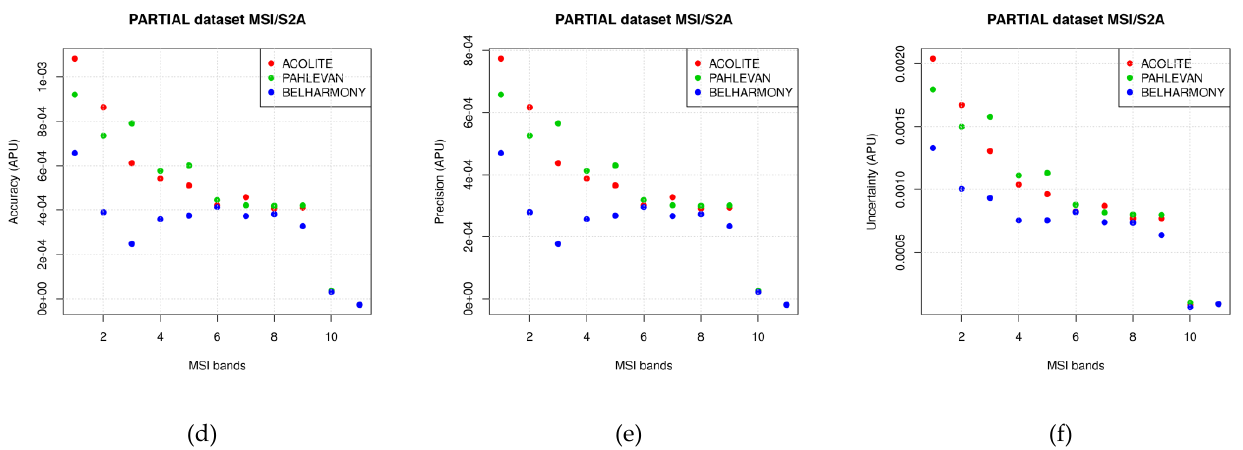
Figure 10. Accuracy ( a,d ), precision ( b , e ), and uncertainty ( c,f ) (APU) of the ACOLITE Rrs with Pahlevan and Belharmony gains and without gains for all the bands of OLI/L8 (above) and MSI/S2A (below).